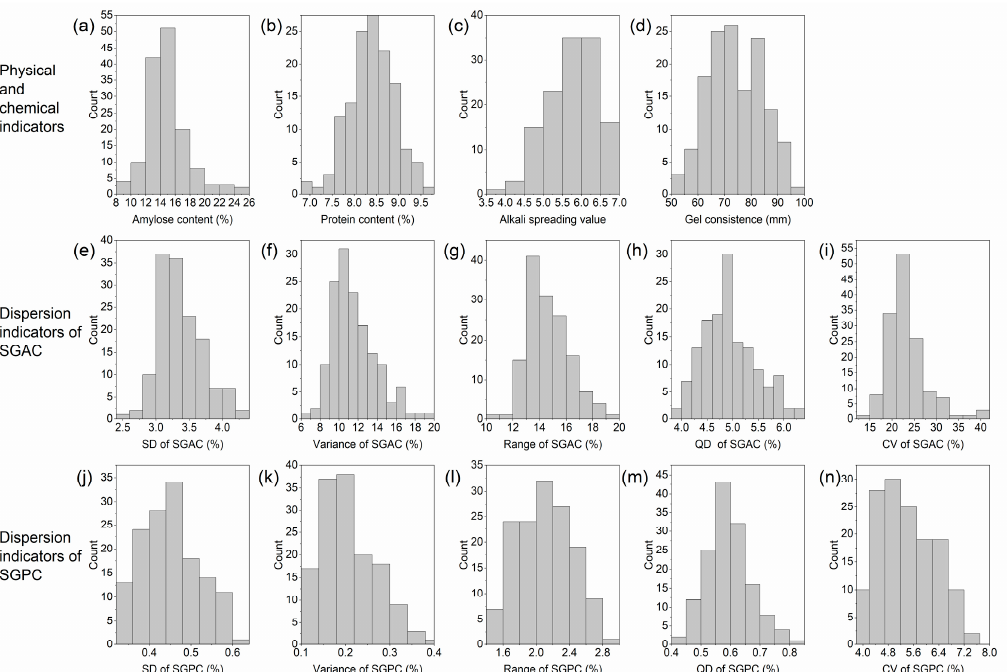
Figure 4. Distribution of physicochemical indices (amylose content, protein content, alkali-spreading value, and gel consistency) and dispersion indicators (SD, variance, range, quartile deviation (QD), and CV) of SGAC and SGPC of hybrid indica rice ( n = 143). ( a – d ): physicochemical indicators, ( e – i ): dispersion indicators of SGAC, and ( j – n ): dispersion indicators of SGPC.